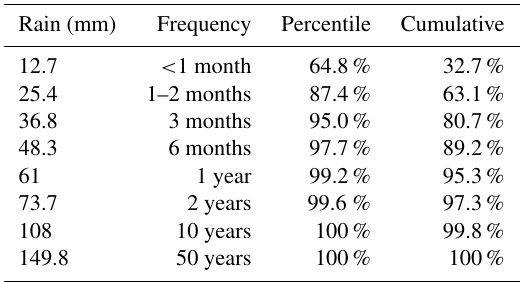
The percentile and cumulative percentage-based statistics qualify the exceedance probability of each event and the relative contribution of events of similar size or lower to the annual rainfall,